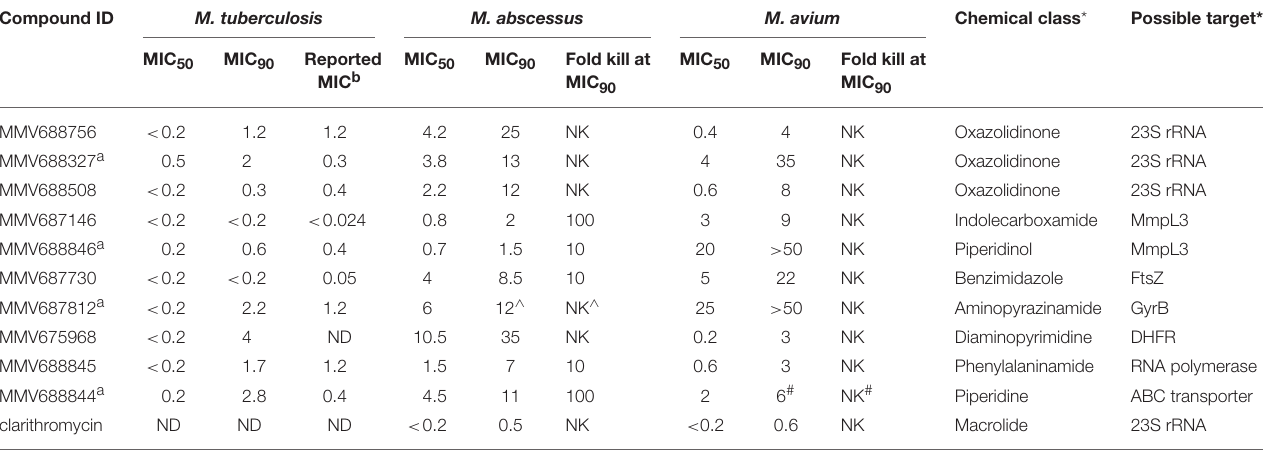
TABLE 1 | Antimycobacterial activities ( µ M) of top NTM hits identified in the Pathogen Box screen. Compound